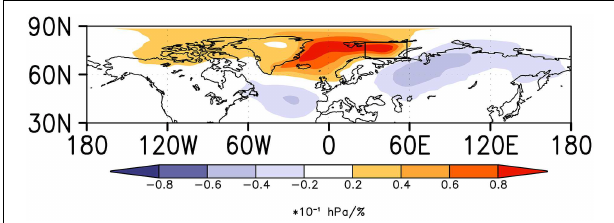
FIGURE 8 | Surface pressure regressed on sea-ice concentration in the Barents Sea. Sea-ice time series selected from the region indicated by the box. The data are based on the Coupled Model Intercomparison Project through the Max Planck Institute Earth System Model, CMIP5 MPI-ESM, control integration. Units: Coloring shows the change in hPa per one percent sea-ice concentration change multiplied by